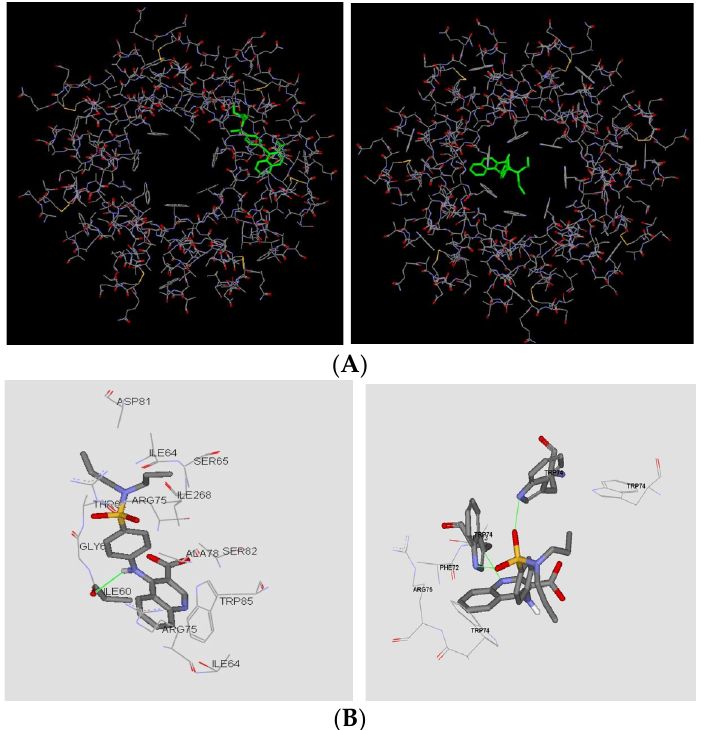
Figure 10. Docking of compound 13e . Two lower-energy poses of 13e in the extracellular domain of the PANX1 channel (panel A ). Particular of the hydrogen bond interactions between 13e and the Ile60 and Trp74 (panel B ).